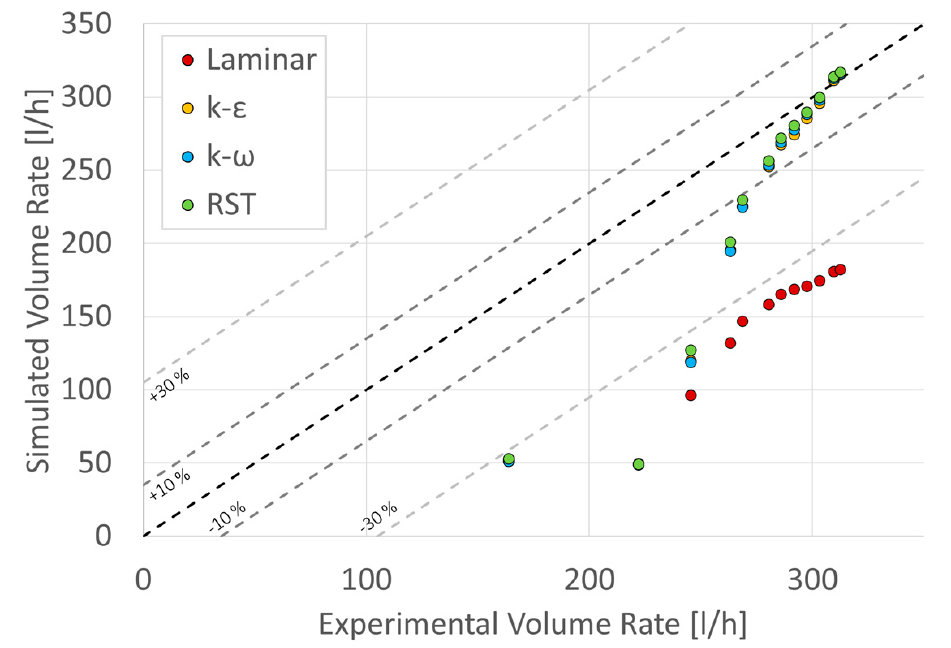
Figure 18. Percentual differences between simulated results for one laminar and three turbulence models based on RANS formulation (k- ε , k- ω , and RST) contrasted with the experimental data. The behavior for high volume rates was close to the experimental values (around ± 10%). As the variable decreased, the RST model presented a lower percentage error; however, the difference between the two-equation models was less than 1%. All values of the laminar curve had an error between − 30% and − 50%, which indicated that the model did not correctly predict the experimental results, contrary to Askvik and Johannessen’s statement. Since the computational cost of solving a simulation with RST is higher than solving it with either k- ε or k- ω , it is recommended to use the two-equation models because the difference in results is small. The simulation results showed that for low- pressure differentials, the flow rates were lower compared to the experimental values; calculating the Reynolds number using the lowest volumetric flow determined that the flow was in transition; this should be considered because there are turbulence models for low Reynolds numbers that are capable of describing regimes in transition